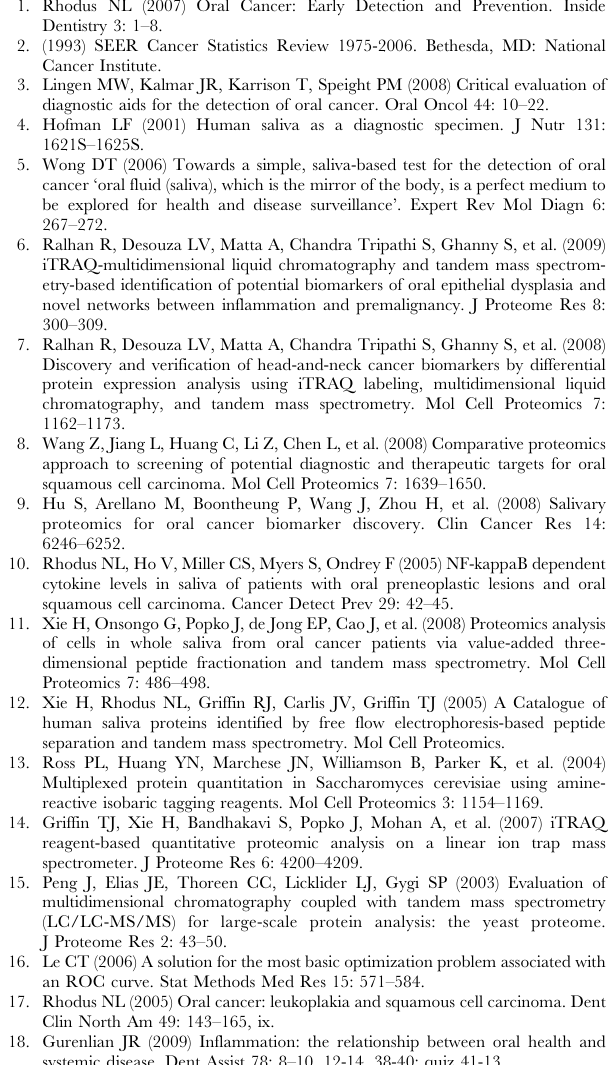
Figure S1 Western blotting images from validation studies. Lanes marked with ‘‘R’’ denotes the reference sample; each numbered lane is a sample from a different individual with either a pre-malignant or malignant oral lesion. Approximate positions of the molecular weight standards, in kDa, are